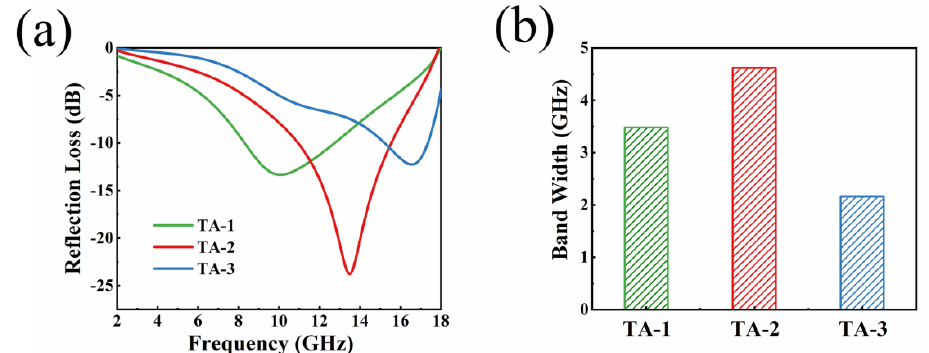
Figure 5. Absorbing properties of composite materials: ( a ) reflection loss, ( b ) effective loss band- width.